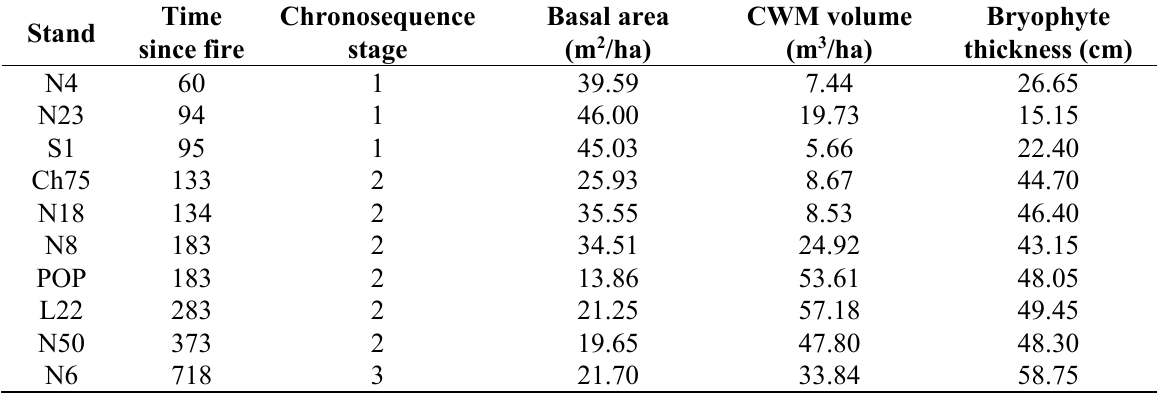
Table 1. Characteristics of a chronosequence black-spruce/feather moss stands used in this study 1